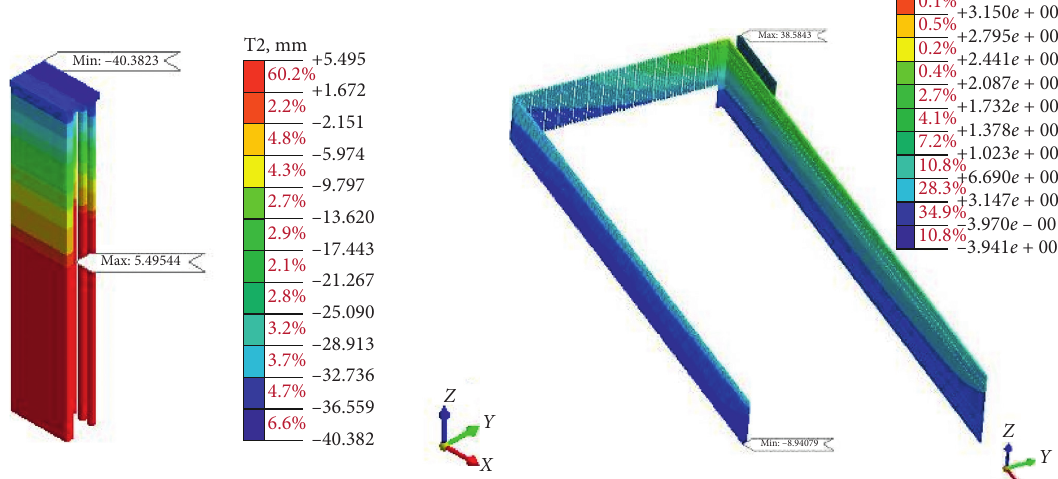
Figure 15: Displacement of supporting structure (mm) after the excavation of the foundation pit without backfilling of the wharf.